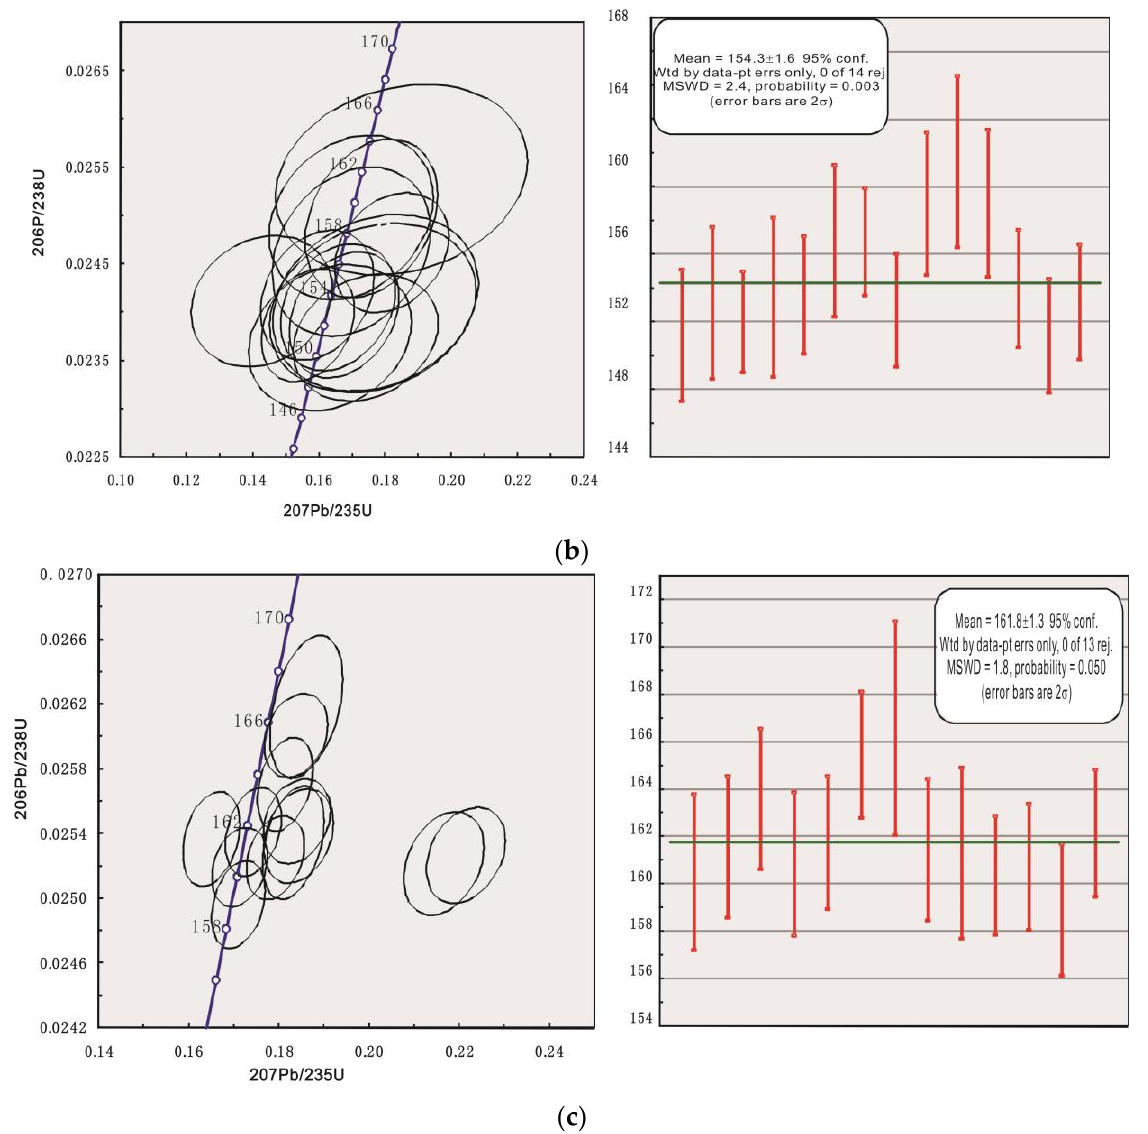
Figure 8. Zircon LA-ICP-MS U–Pb concordia diagrams for the samples XTL-200-01 ( a ), XTL-06 ( b ), XTL-340 ( c ). Table 6. LA-ICPMS U–Pb zircon dating data of the XTL200 from the Xintianling deposit.